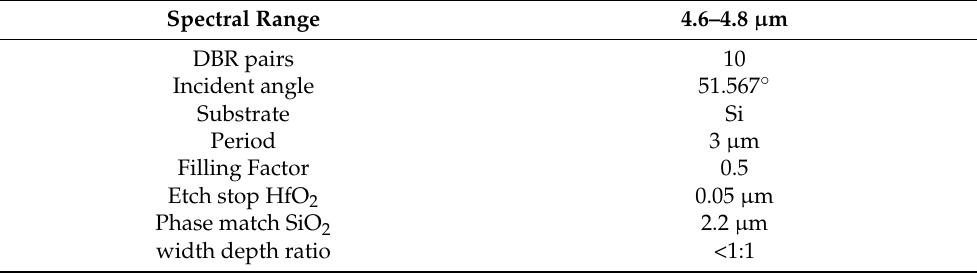
Figure 3. Brief structure demonstrating the pure silicon grating for comparation. The grating con- sists only of silicon material. Table 5. Parameter of reflective grating to determine the phase match layer of SiO 2 .